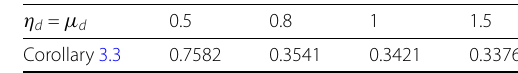
Table 1 MAUBs of η 2 = μ 2 for different η d = μ d